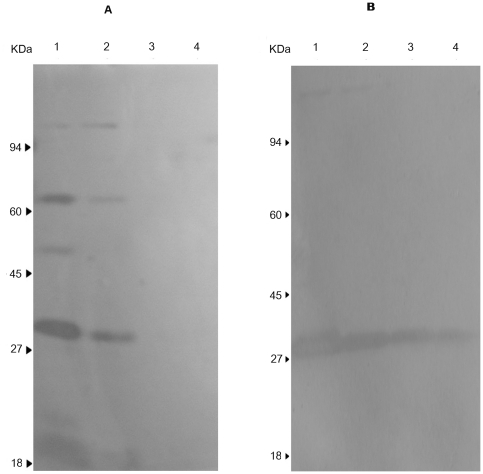
Zymographic analysis of bacteriolytic hydrolase activities of S. aureus ATCC 25923 cells treated with MOL.LiCl (A) and SDS (B) autolysin extracts containing S. aureus ATCC 25923 cell walls treated with various concentrations of MOL. Lane 1, no MOL treatment; lane 2, 1/4× MIC MOL; lane 3, 1/2× MIC MOL; lane 4, 1× MIC MOL. Molecular size markers are indicated on the left. The data shown are from a single representative experiment and were reproduced several times.